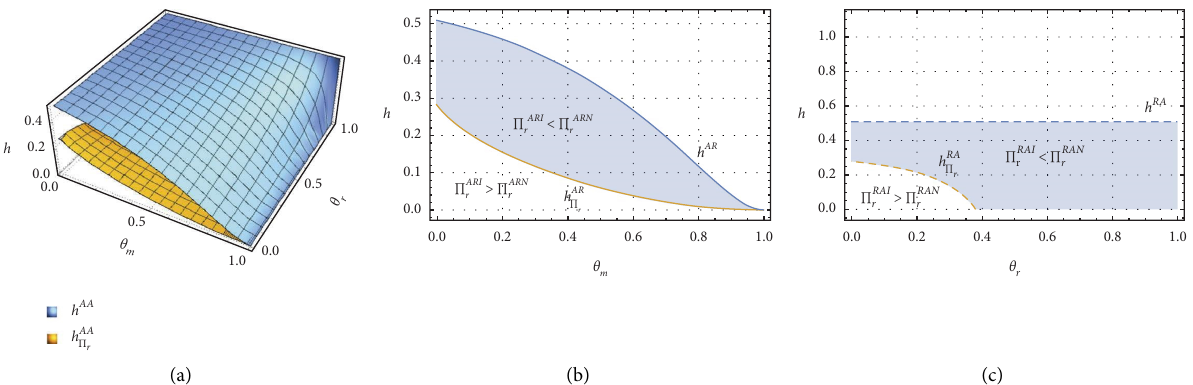
Figure 4: Tresholds of the retailer’s profts for diferent altruistic scenarios ( a � 1 , b � 0 . 5 ,c � 0 . 2 , c � 1 ) . (a) Both members are altruistic. (b) Only the manufacturer is altruistic. (c) Only the retailer is